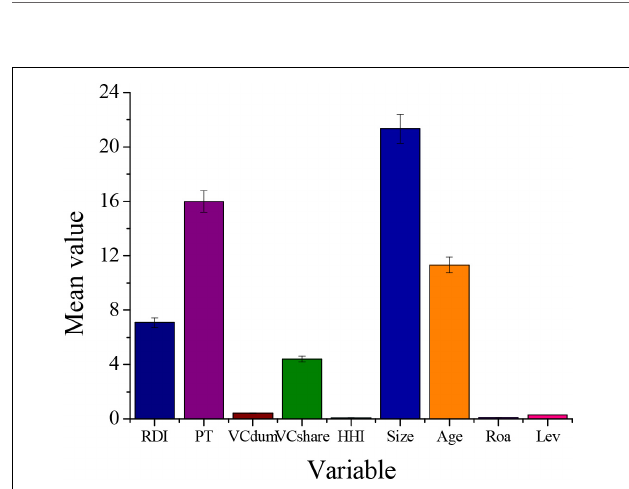
FIGURE 2 | Descriptive statistics for each